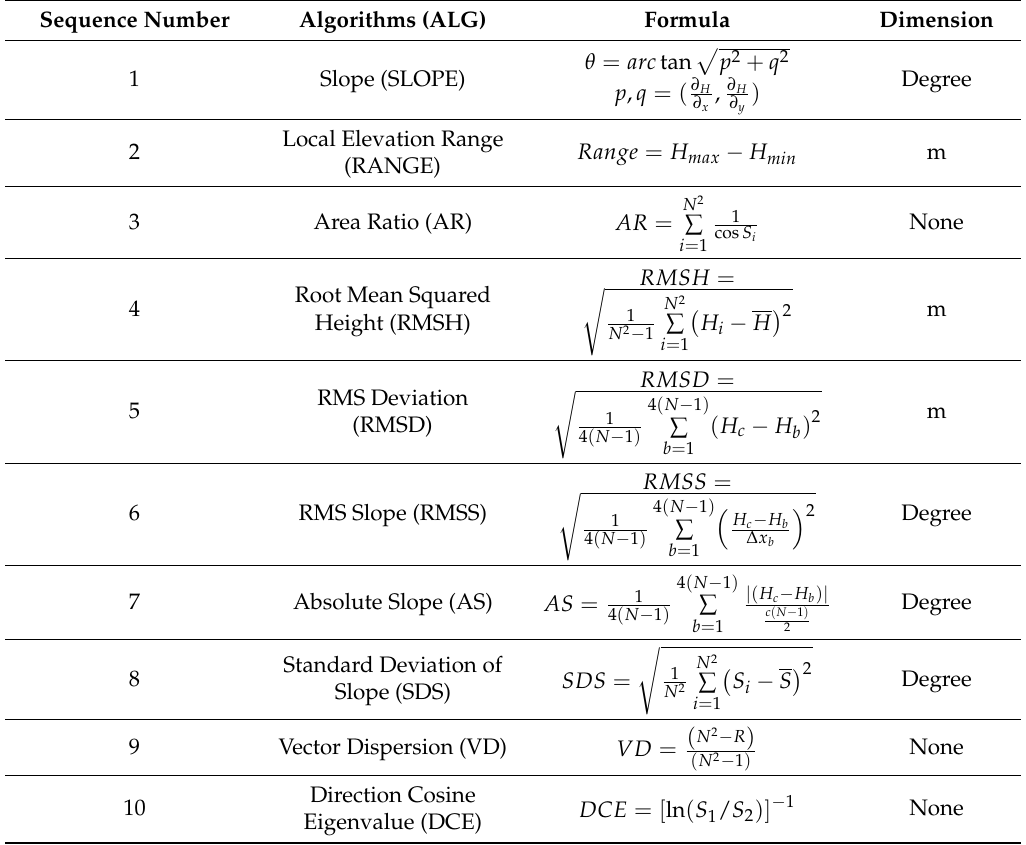
Table 1. Algorithms of